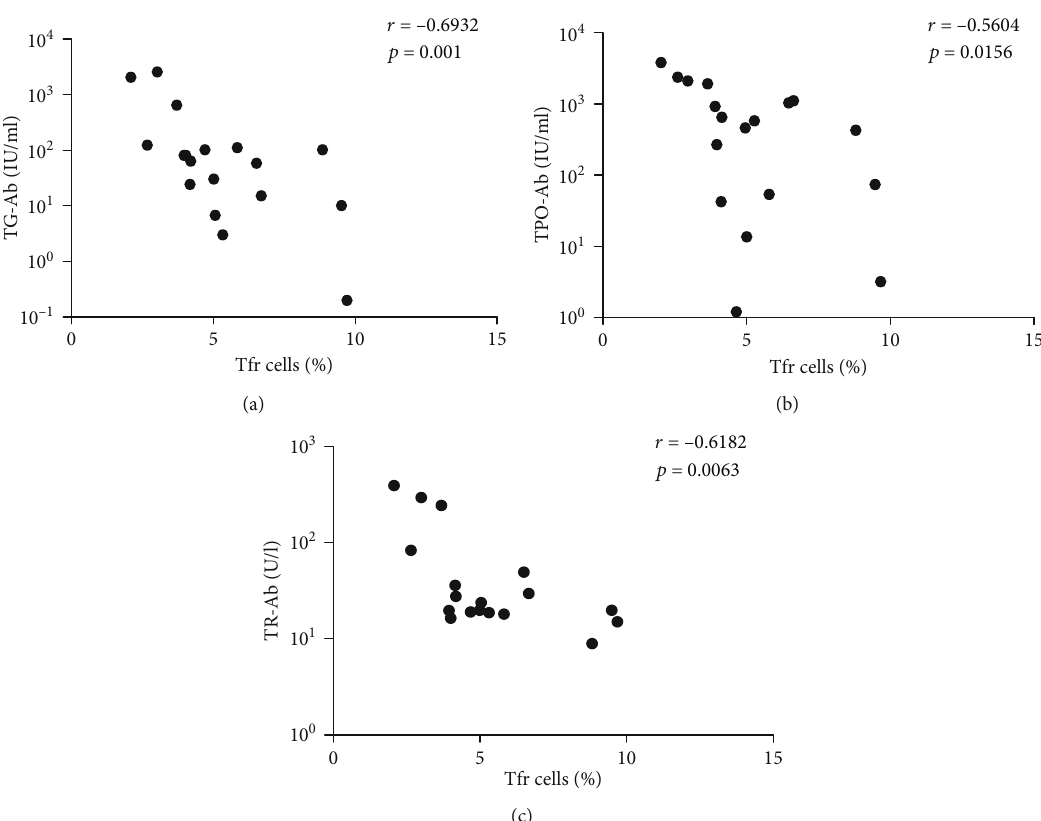
Figure 4: The correlations between the proportion of Tfr cells in PBMCs and the levels of (a) TR-Ab, (b) TPO-Ab, and (c) TG-Ab in serum from the patients with